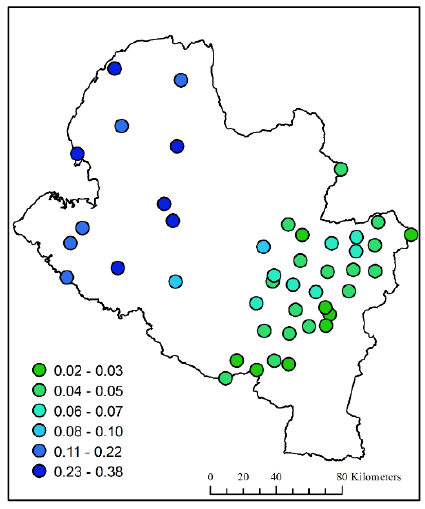
Figure 5. The first spatial pattern of monthly rainfall in Southwestern Colombia. Figure 5 . The first spatial pattern of monthly rainfall in Southwestern Colombia .